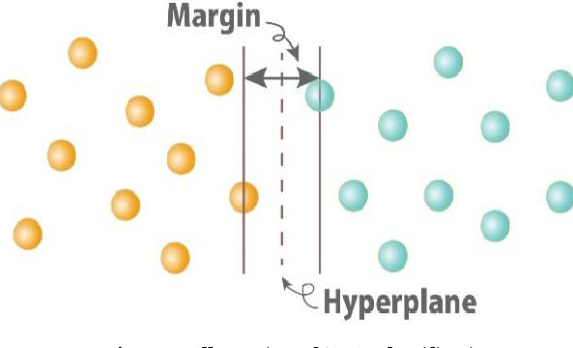
Figure 1 . Illustration of SVM